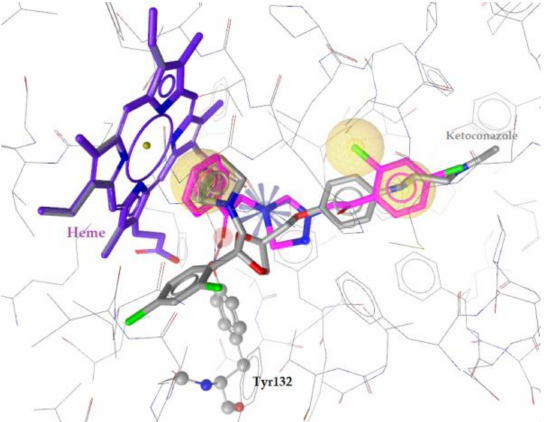
Figure 4. The superposition of the most active compound 19 (magenta) and Ketoconazole (grey) in lanosterol 14 α -demethylase of C . albicans (CYP51 ca ). The heme group is represented in purple color.